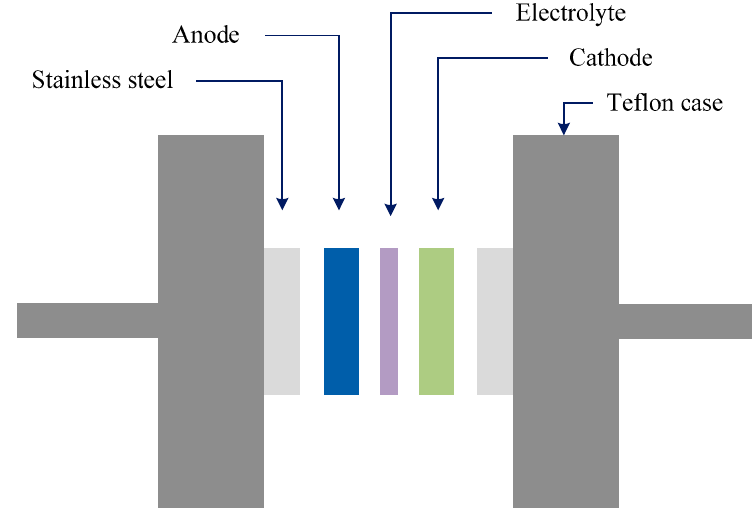
Figure 9. Cyclic voltammetry (CV) plot of the fabricated electrical double layer capacitor (EDLC) from CSDX4 film in the potential range of 0 V to 1 V.